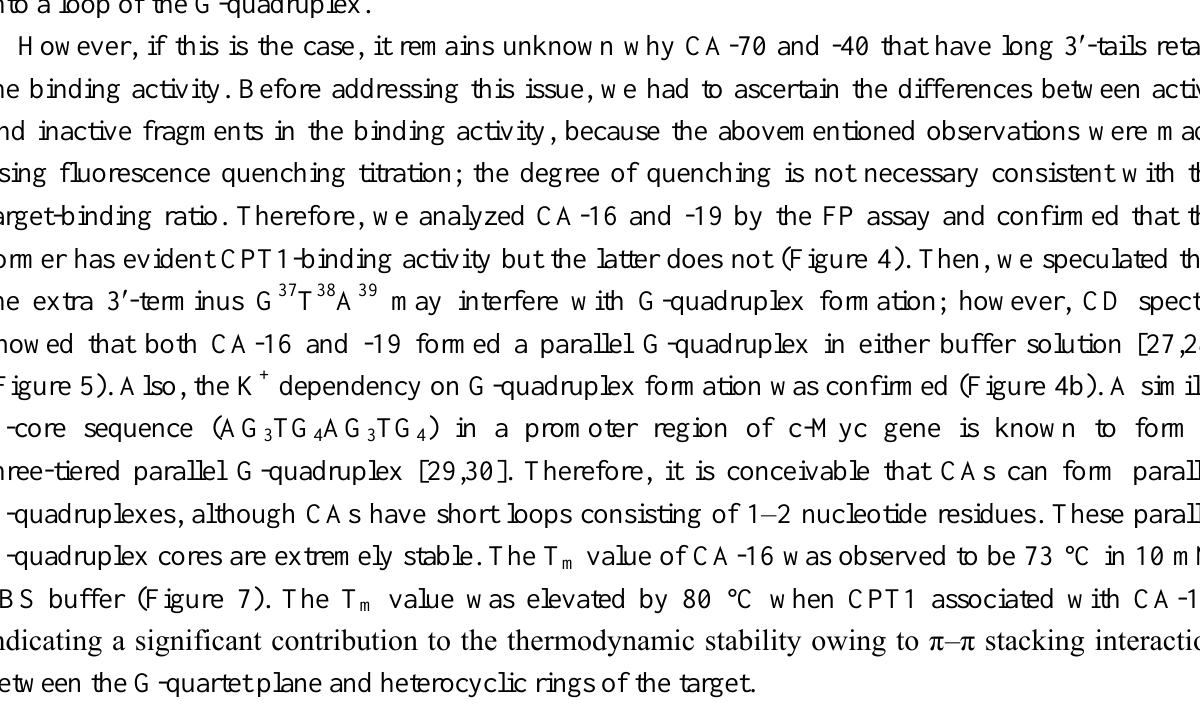
Figure 7. Melting curves for CA-16 in the presence (red) and absence (black) of CPT1, which were obtained by plotting the ellipticity at 265 nm against the